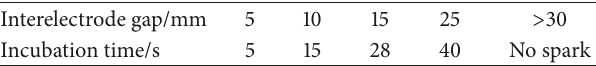
Table 3: Summary of SMAO incubation times obtained for different interelectrode gaps testing.